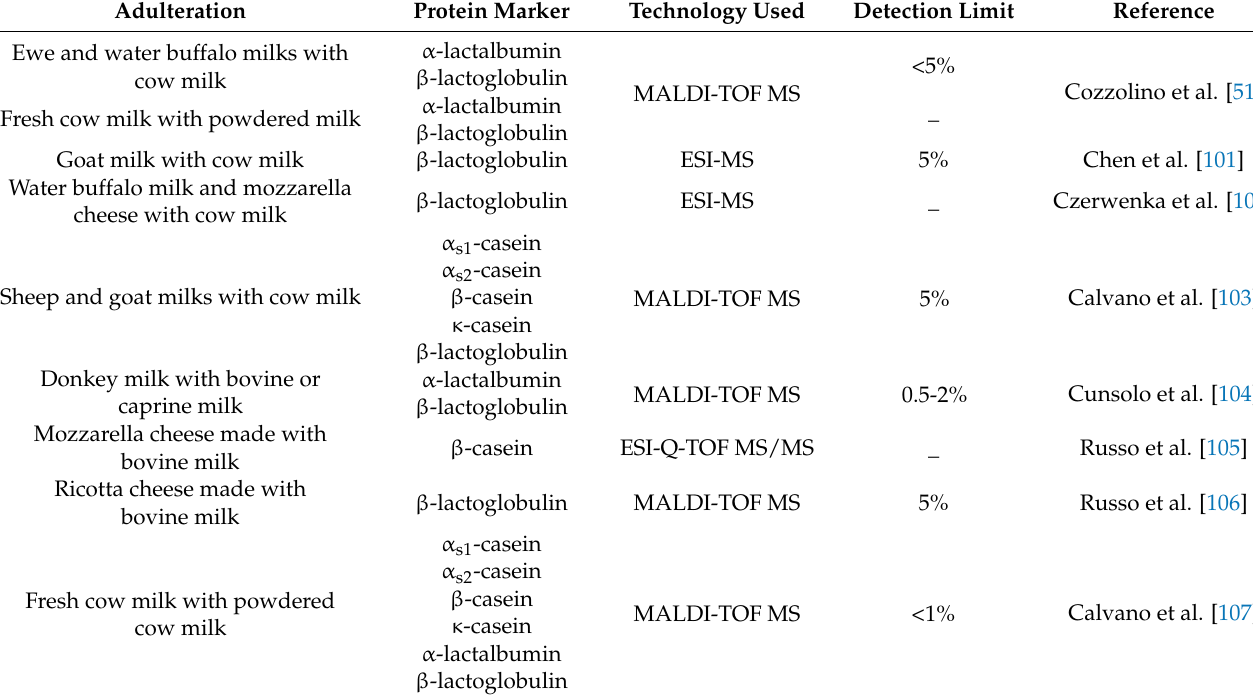
Table 3. Modified milk proteins after adulteration (markers) found in original research